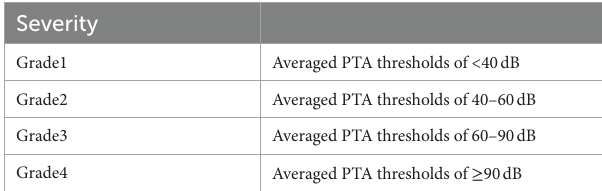
TABLE 1 The severity of hearing loss grade by the guidelines of the Japanese ministry of health and